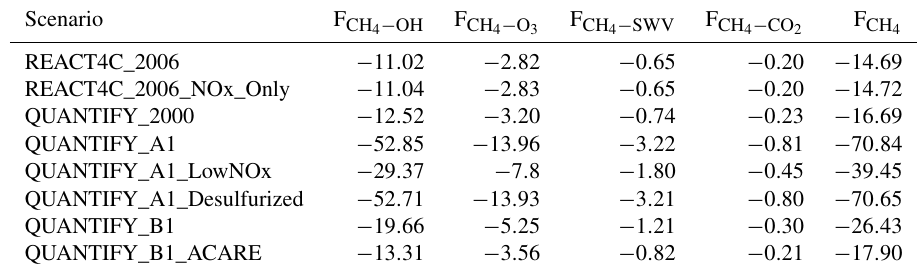
into its various direct and indirect forcings. The forcings are associated with Table 6. Decomposition of the total methane forcing F CH 4 changes in methane lifetime (CH 4 − OH), tropospheric ozone production (CH 4 − O 3 ), stratospheric water vapour production (CH 4 − SWV) and CO 2 production (CH 4 − CO 2 ) (mWm − 2